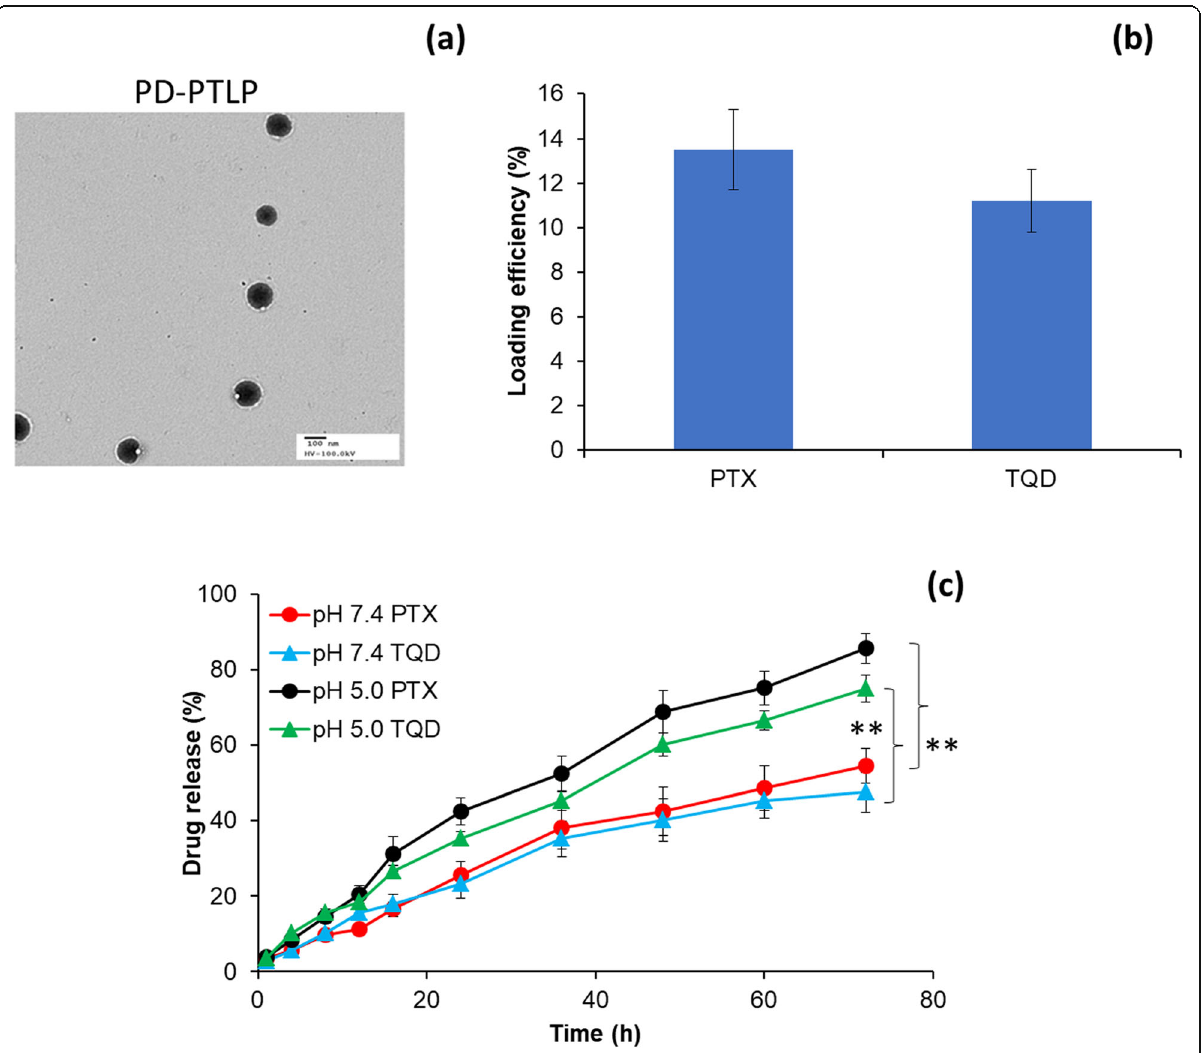
Fig. 2 Physicochemical characterization of PTX/TQD-loaded PD-L1-conjugated nanoliposome. a Morphology analysis of PD-PTLP using transmission electron microscope (TEM). b Drug loading capacity of PD-PTLP. c In vitro release of PTX and TQD from PD-PTLP at pH 7.4 buffer and pH 5.0 buffer conditions at 37 °C. ** p < 0.01 is the statistical difference in drug release between pH 7.4 and pH 5.0